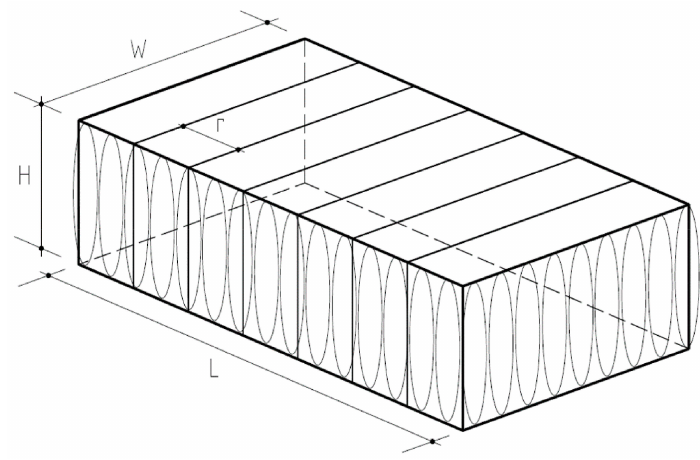
Figure 2. Scheme of basic dimensions of a tyre bale. Table 1. Basic dimensions and weights of tyre bales used in the current research.